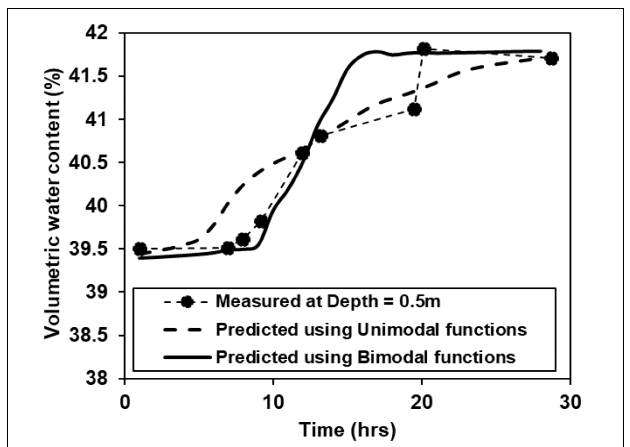
FIGURE 9 | Comparison between measured and predicted ( k sat = 10 − 3 m/h for unimodal function) volumetric water content at the depth of 0.5 m.